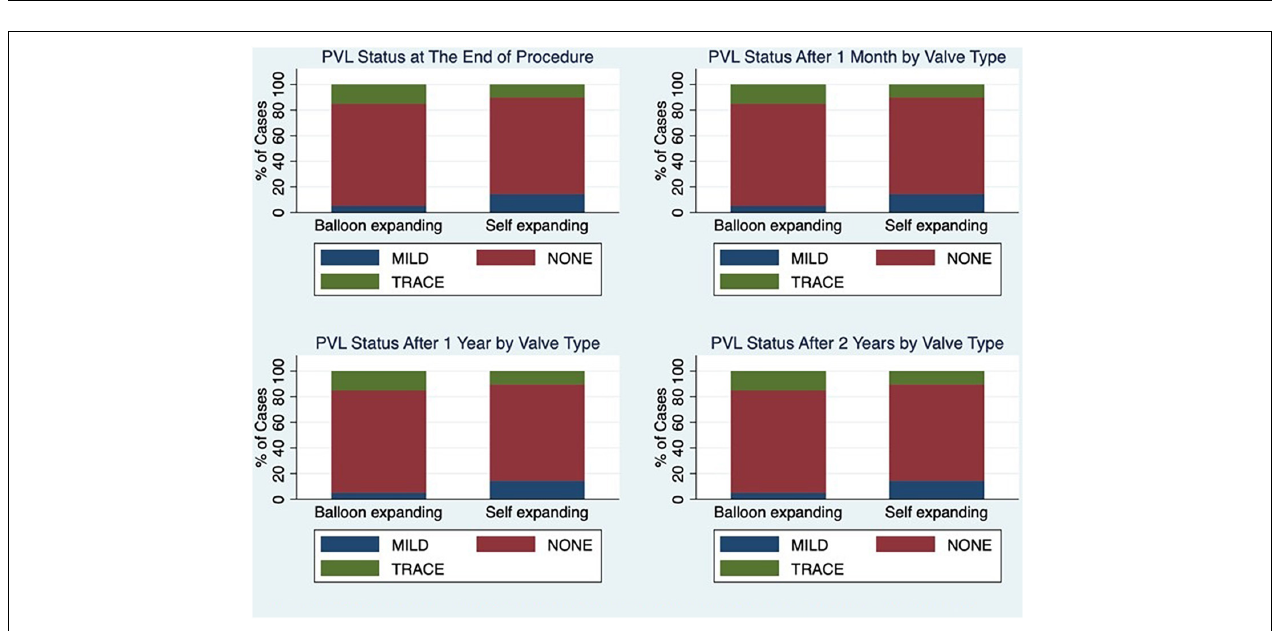
FIGURE 1 | Pair wise comparison of mean pressure gradients over 2 years, statistically significant.